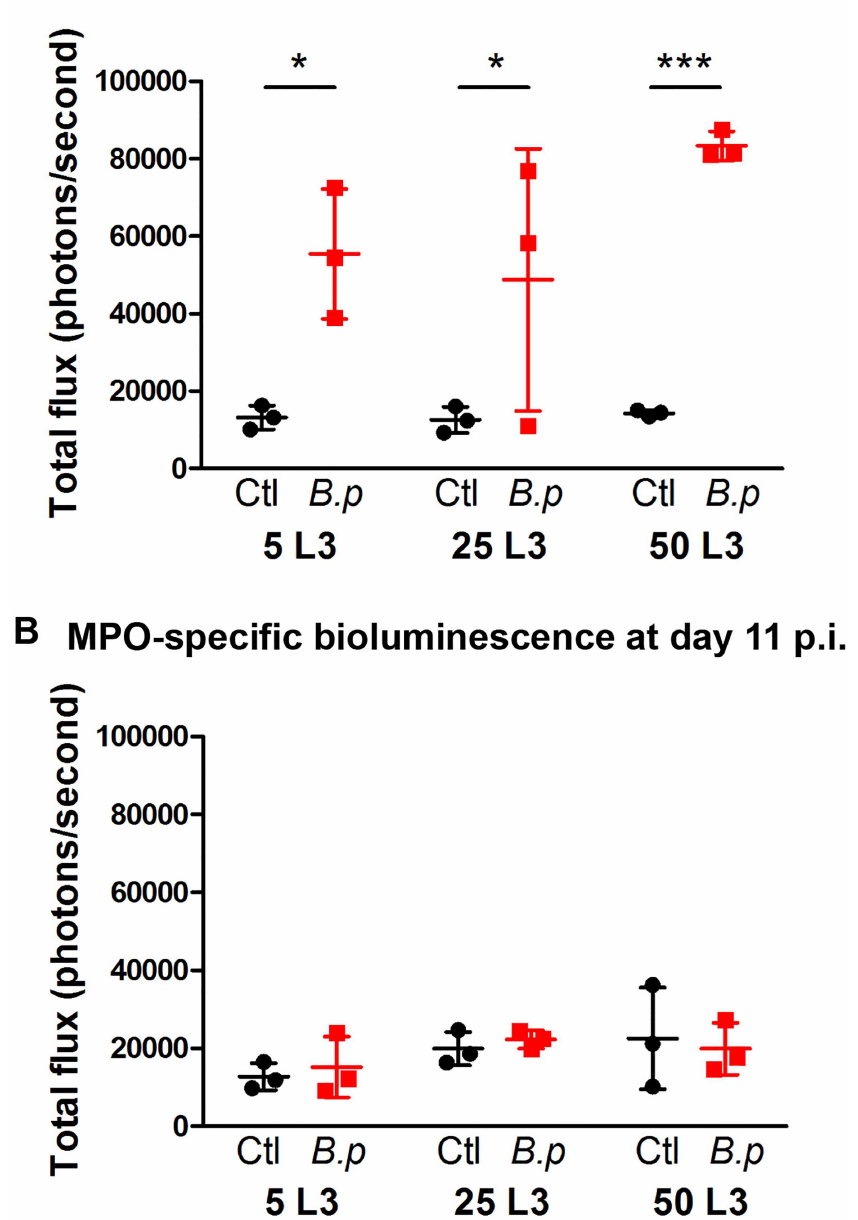
Fig 3. MPO-specific bioluminescence after infection with different doses of B . pahangi . BALB/c mice were injected with 5, 25 or 50 L3 of B . pahangi into the RHS footpad ( B . p )and with HBSS into the LHS footpad (Ctl). On day 5 ( A ) and day 11 ( B ) post-infection mice were imagedusing an IVIS spectrum 20 minutes after subcutaneous injectionof 200 mg/kg luminol. Graphs show the bioluminescence total flux (in photons/ second)within the footpad regionof interest. Each symbol shows the total flux for a single mouse, lines indicatethe means (n = 3 mice per L3 dose) and error bars show SD ( * p < 0.05, *** p < 0.001 using two-way ANOVA with Bonferroni